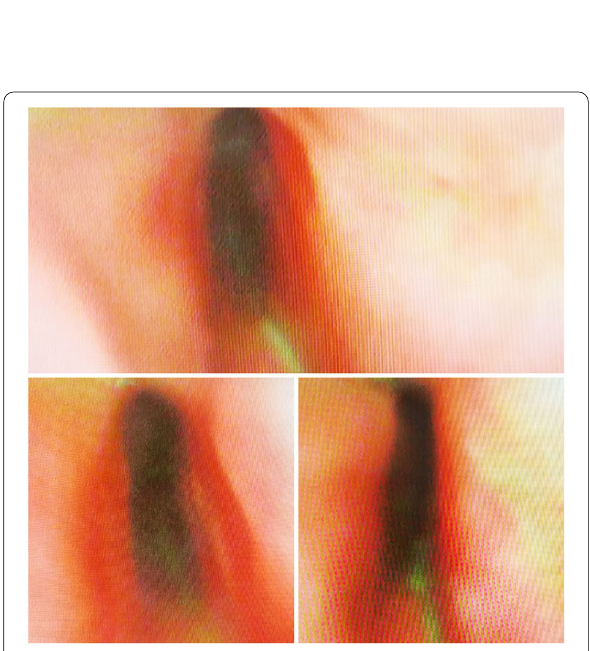
Fig. 5 Follow-up in 1 year after surgery. No recurrence or other nasal anomalies have been visible and nasal endoscopy showed a well-aligned